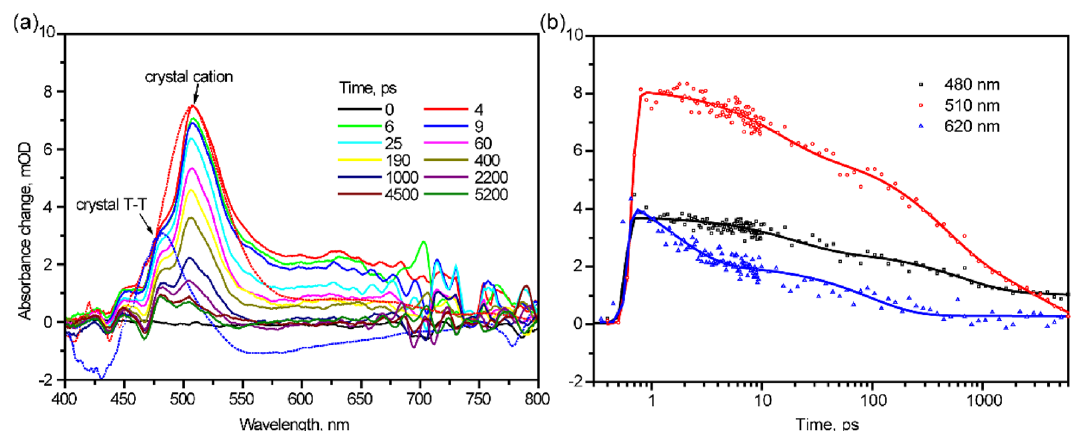
Figure 4. Femtosecond transient absorption spectra (a) and kinetics (b) in perylene film, λ ex = 250